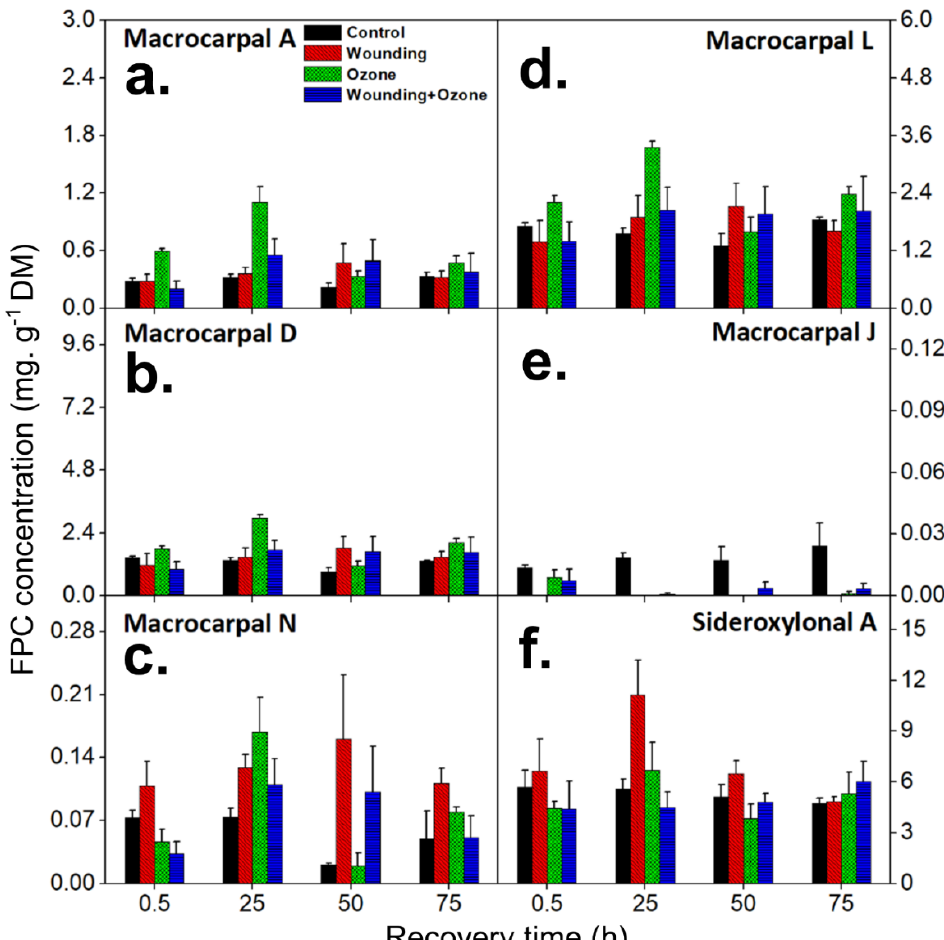
Figure 3. Temporal changes in individual FPCs (means ± SE, n = 3) in E. globulus leaves subjected to separate and combined ozone ( O 3) and wounding treatments. Linear mixed models were applied to analyze the fixed effects of different treatments (wounding, O 3 , and O 3 + wounding) and recovery times on the temporal changes in FPCs concentrations in E. globulus leaves. The summary of the linear mixed model is shown in Table 2.